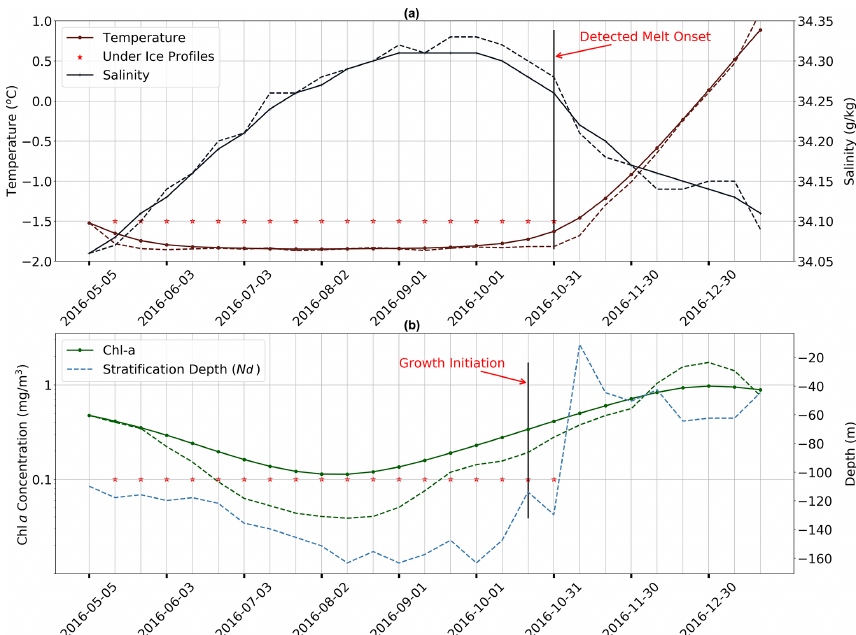
Figure 2. Time series of key properties illustrating the methodology used for melt and growth detection. (a) Near-surface temperature (dark red) and salinity (grey) from May to December 2016 in the Ross Sea sector (65 ◦ S). Red stars indicate profiles flagged as under ice. Solid lines with markers are filtered time series (higher frequencies have been removed), and dashed lines are raw data. (b) Mean mixed layer Chlorophyll a (dark green) and mixed layer depth plotted for the same period as in (a) . For more information, refer to Sect.